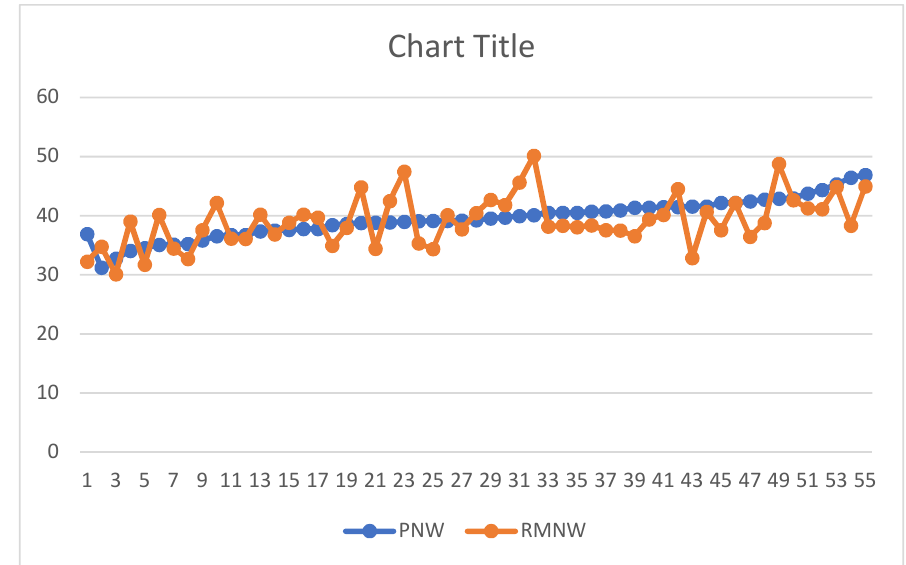
−1.96 s to +1.96 s, where Y = PNW-RMNW, X = (PNW + RMNW)/2.